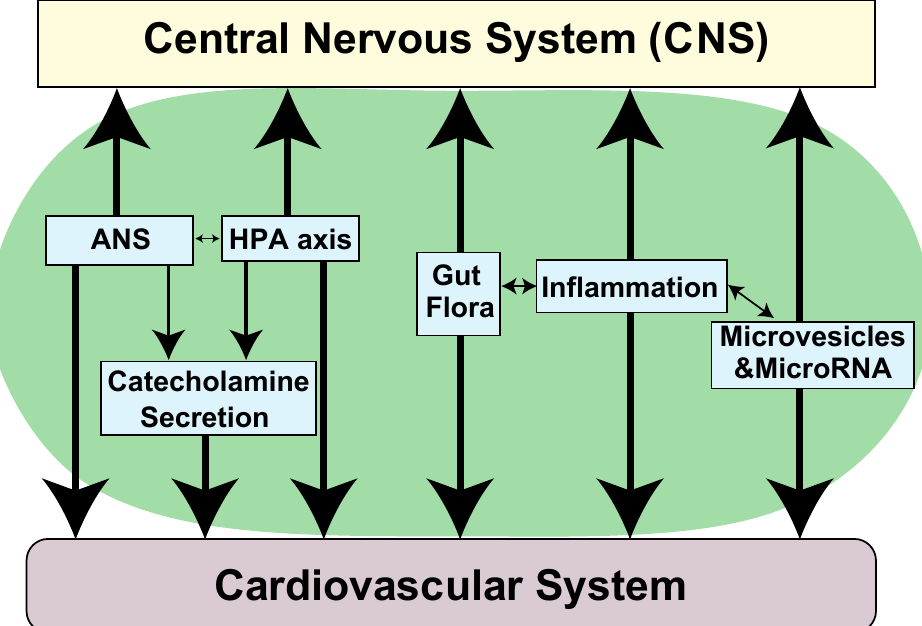
Figure 1. Summary of the brain–heart bidirectional interaction. Cardiac dysfunction and CNS disorders may be related by several mechanisms, including abnormal hypothalamic–pituitary–adrenal (HPA) axis, dysfunction in autonomic nervous system (ANS), catecholamine surge, gut dysbiosis, or systemic inflammation, as well as the release of microvesicles or microRNA.